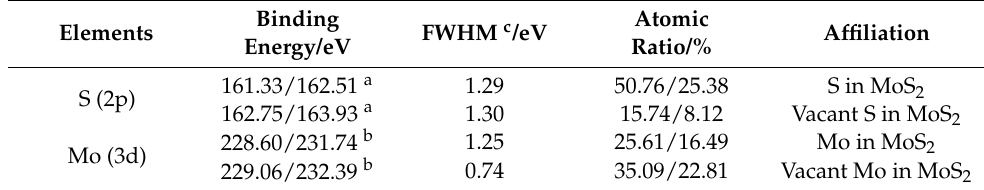
Figure 18. ( a ) Polarization curves and ( b ) Tafel slopes of bulk MoS 2 (blue line), as-prepared MoS 2 monolayer (red line), and Pt (black line), respectively. ( c ) The double-layer capacitances C dl of bulk MoS 2 (blue line), as-prepared MoS 2 mono- layer (red line), ( d ) Nyquist diagrams of bulk MoS 2 (blue square), as-prepared MoS 2 monolayer (red dot) measured at 300 mV overpotential, and ( e ) the polarization durability test of the as-prepared MoS 2 monolayer (red line: Initial state, blue line: After 1000 cycles) [48].